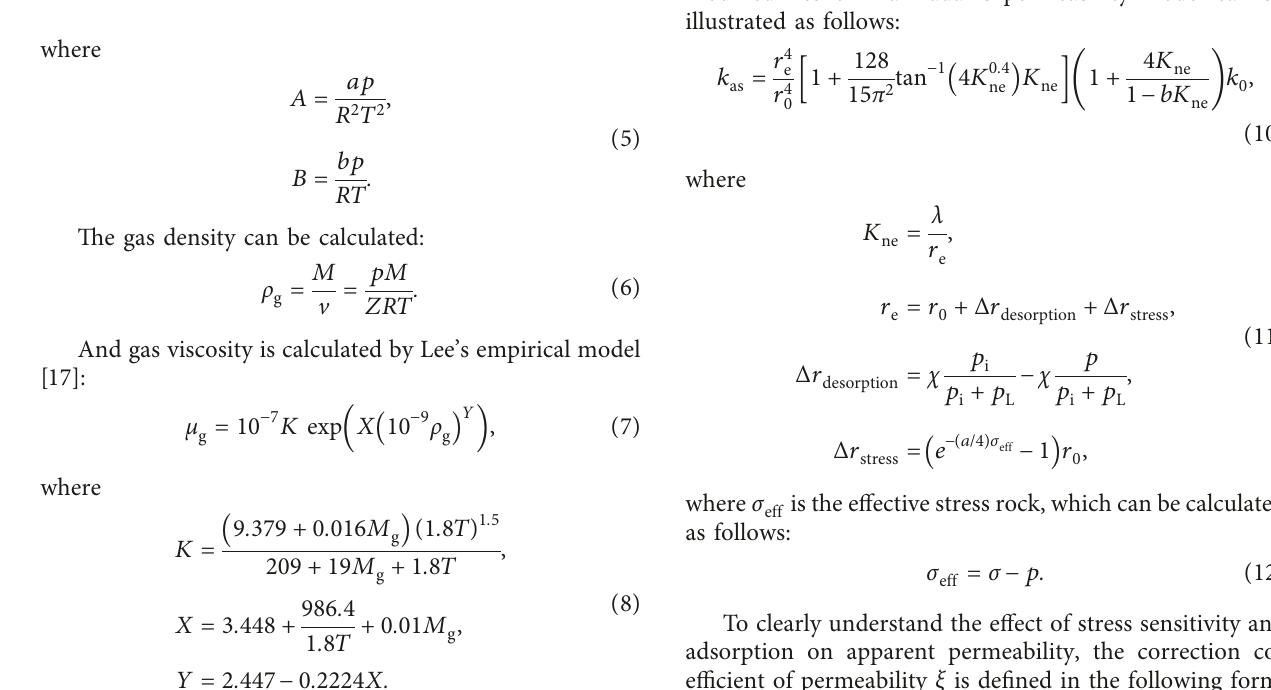
Figure 3: Phase diagram of